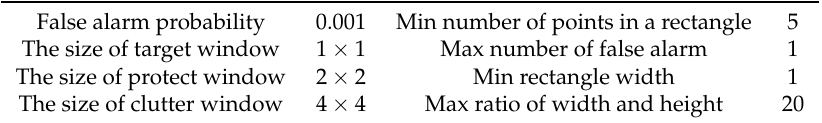
Table 1. Parameter setting of Experiment